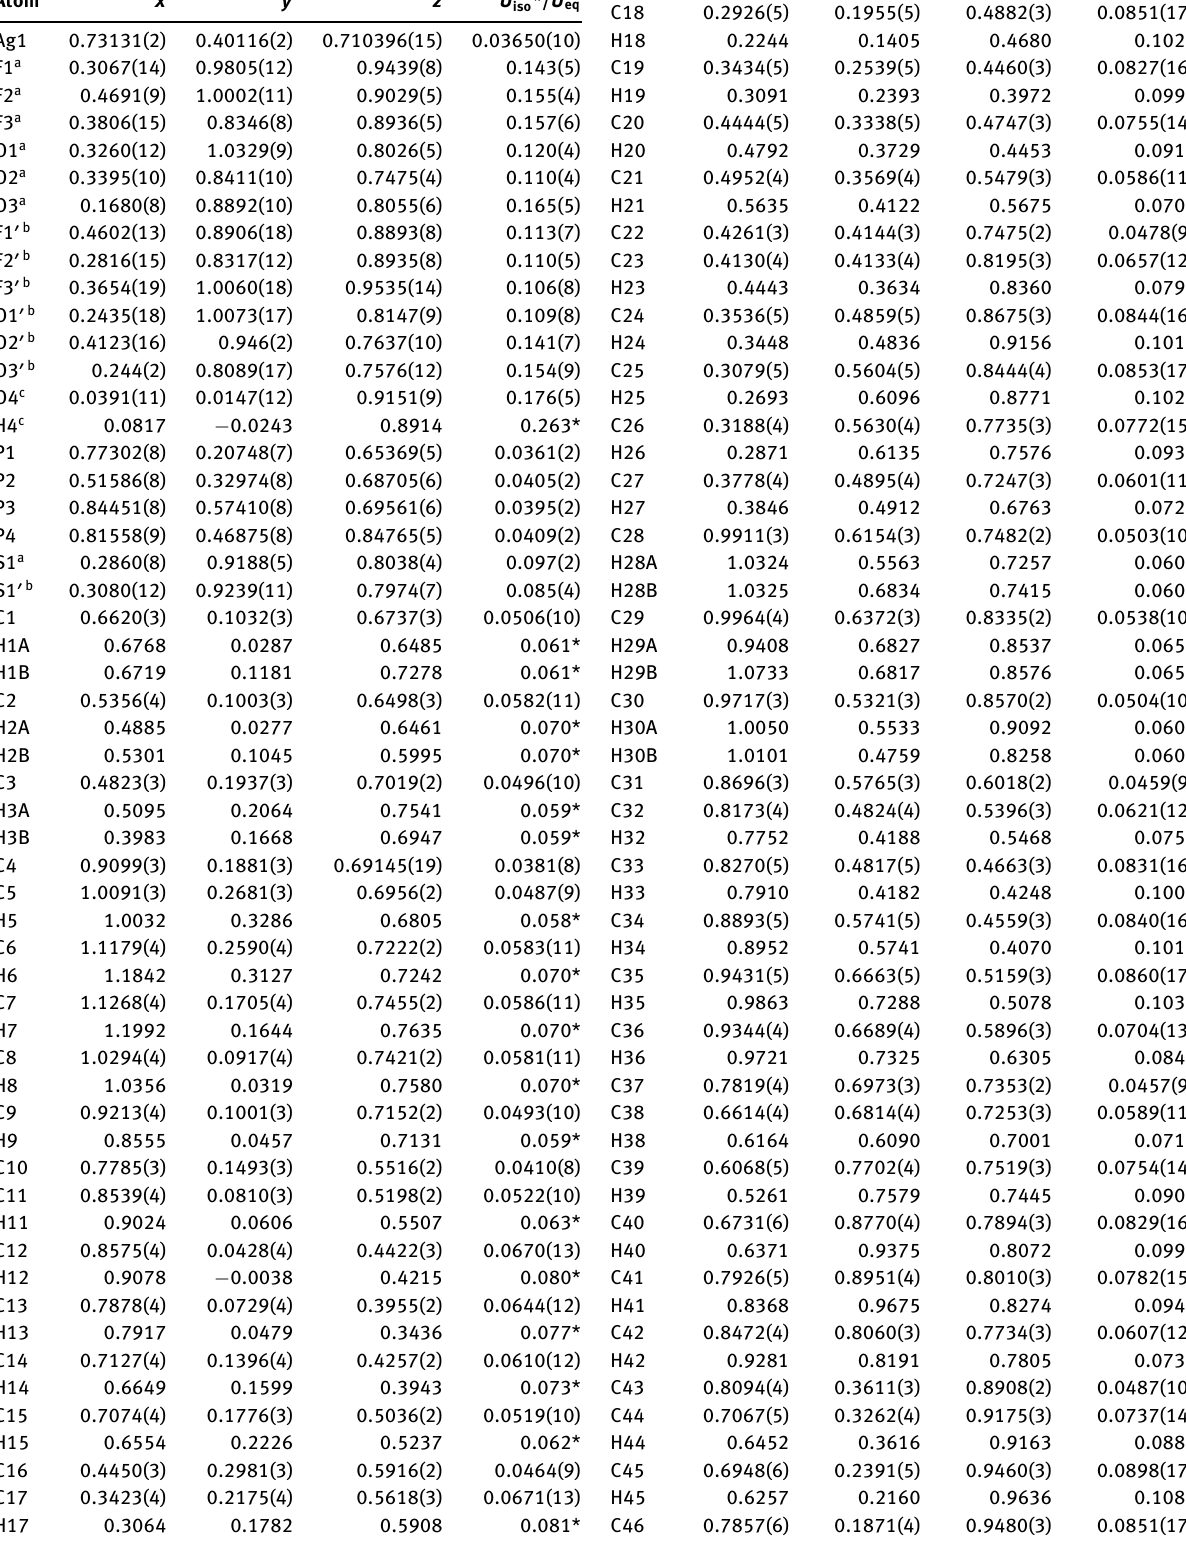
Table 2: Fractional atomic coordinates and isotropic or equivalent isotropic displacement parameters (Å 2